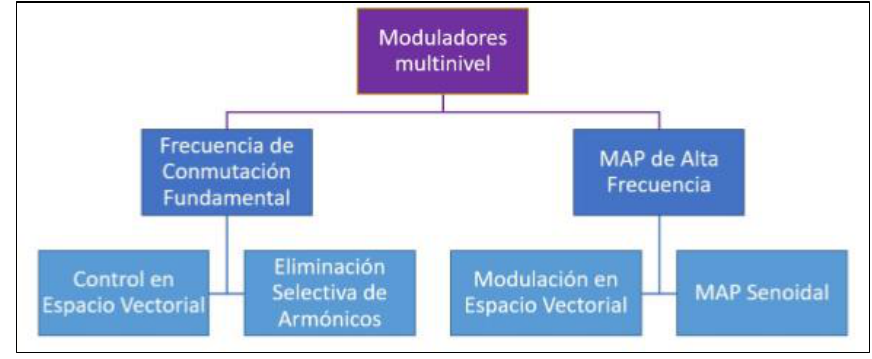
Figure 4: Classification of multilevel modulation methods.